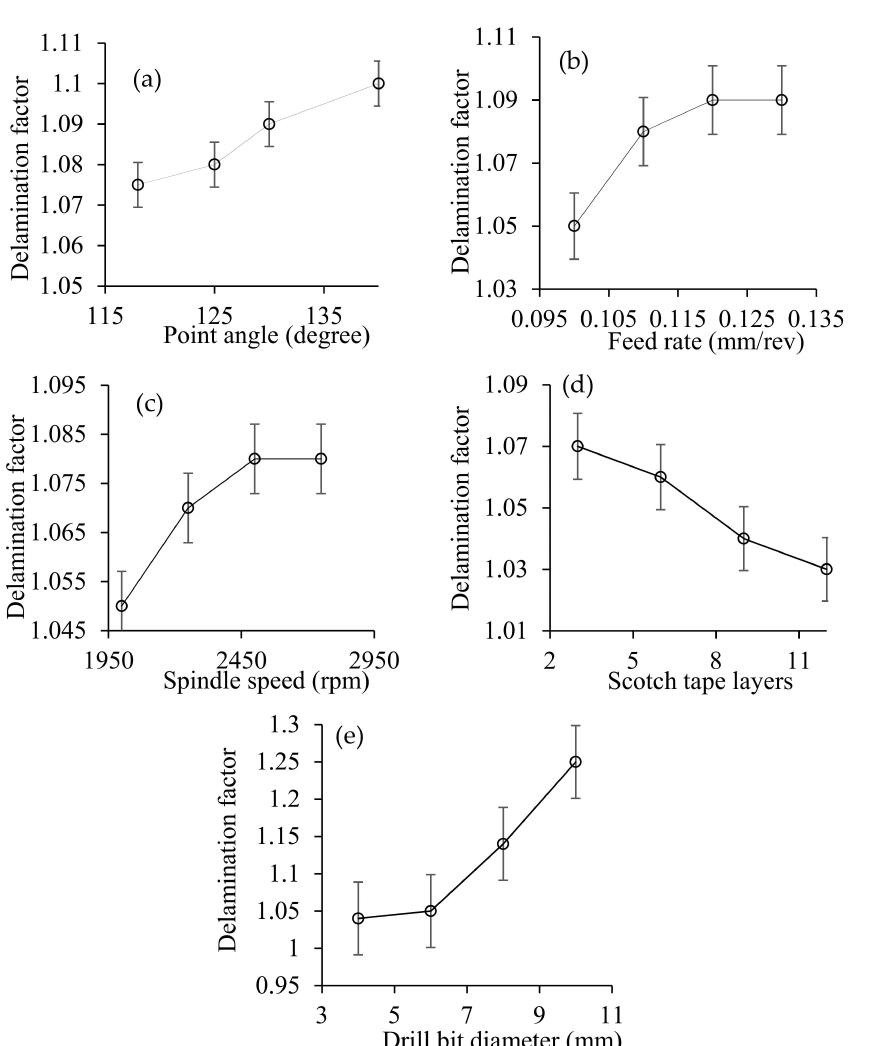
Figure 11. Influence of point angle ( a ), feed rate ( b ), spindle speed ( c ), Scotch tape layers ( d ), and drill bit diameter ( e ) on the delamination factor at the entry of the drilled holes for the similar conditions as presented in Figure 10.